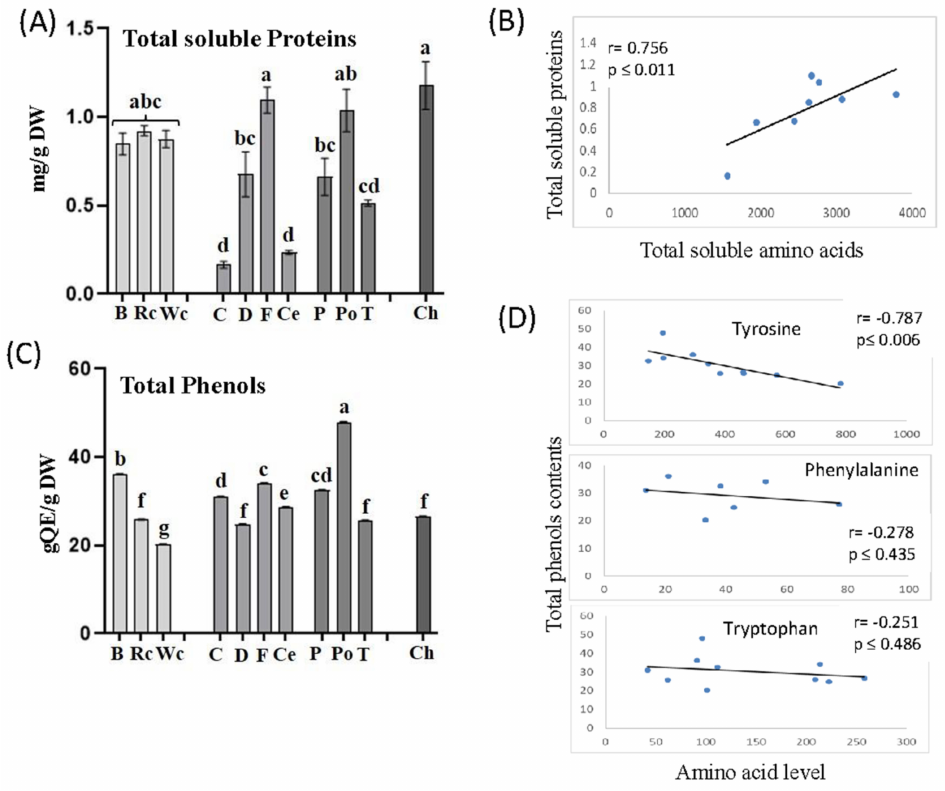
Figure 8. The total soluble proteins ( A ) and total phenol contents ( C ) in the parasites that developed on 10 different hosts. Pearson’s correlation coefficient analyses between total soluble amino acids and total soluble proteins ( B ) or between the levels of three aromatic amino acids and total phenol contents ( D ). Total protein contents in the albumin fraction are measured using the Bradford assay; total phenol contents are represented as mg quercetin equivalents (QE) per mg of dry weight (DW). All data shown are means ± SE of four replicates. The significance is calculated according to the Tukey–Kramer HSD test ( p < 0.05) and is identified by different lowercase